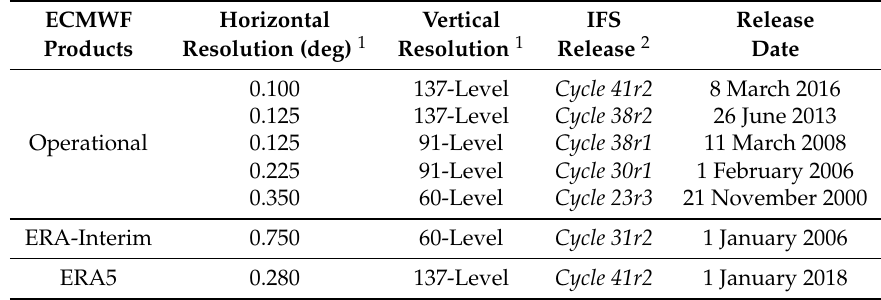
Table 2. Summary of ECMWF reanalysis data sets (ERA-Interim and ERA5) and OP specifications: horizontal resolution in latitude/longitude; vertical resolution model level (ML); IFS release cycle and date [28]. Only releases with major changes, either in spatial resolution or ML, are reported. ECMWF Horizontal Vertical IFS Release